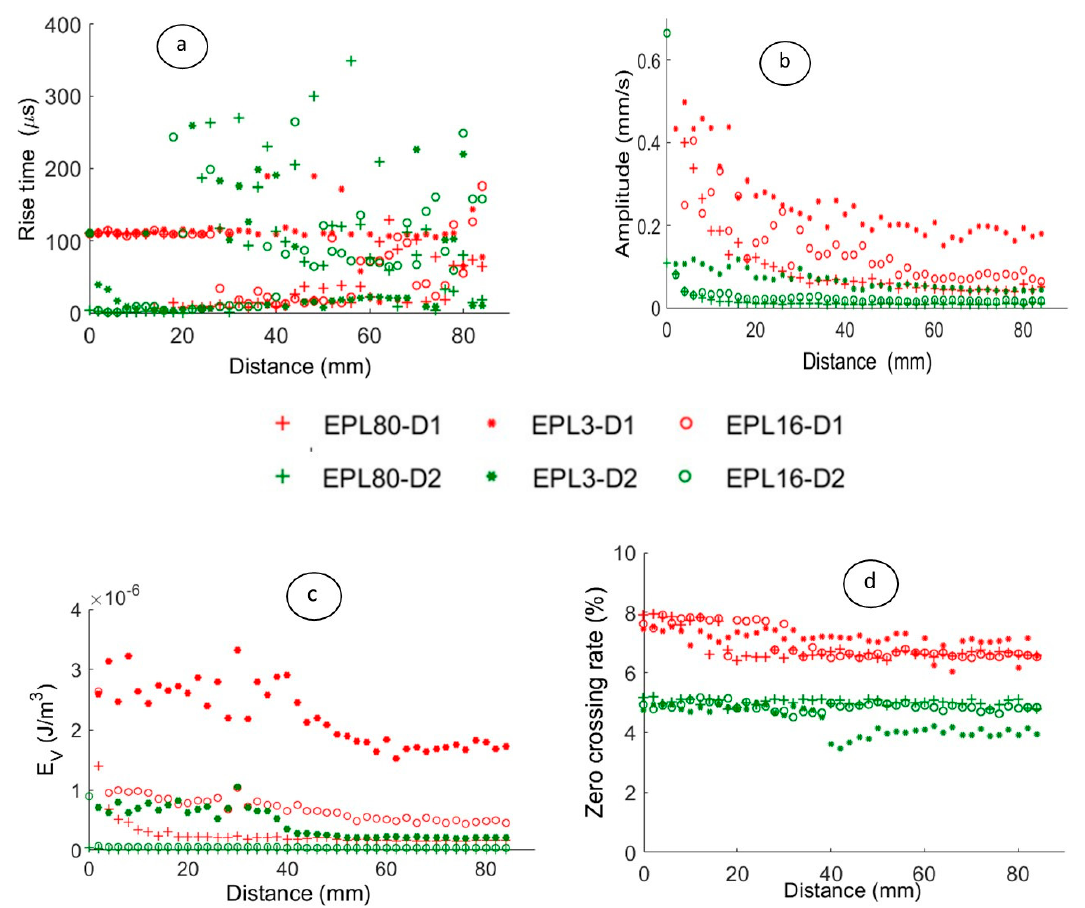
Figure 13. Evolution of four temporal parameters calculated in the time domain as a function of distance from the source for 3 geometries (EPL80, EPL3, EPL16) and 2 sources (D 1 (M x = 500 N · µ m, 0 mm, 0.1 µ s), D 2 (M x = 100 N · µ m, 0.95 mm, 1 µ s)): ( a ) rise time, ( b ) peak amplitude, ( c ) energy, ( d